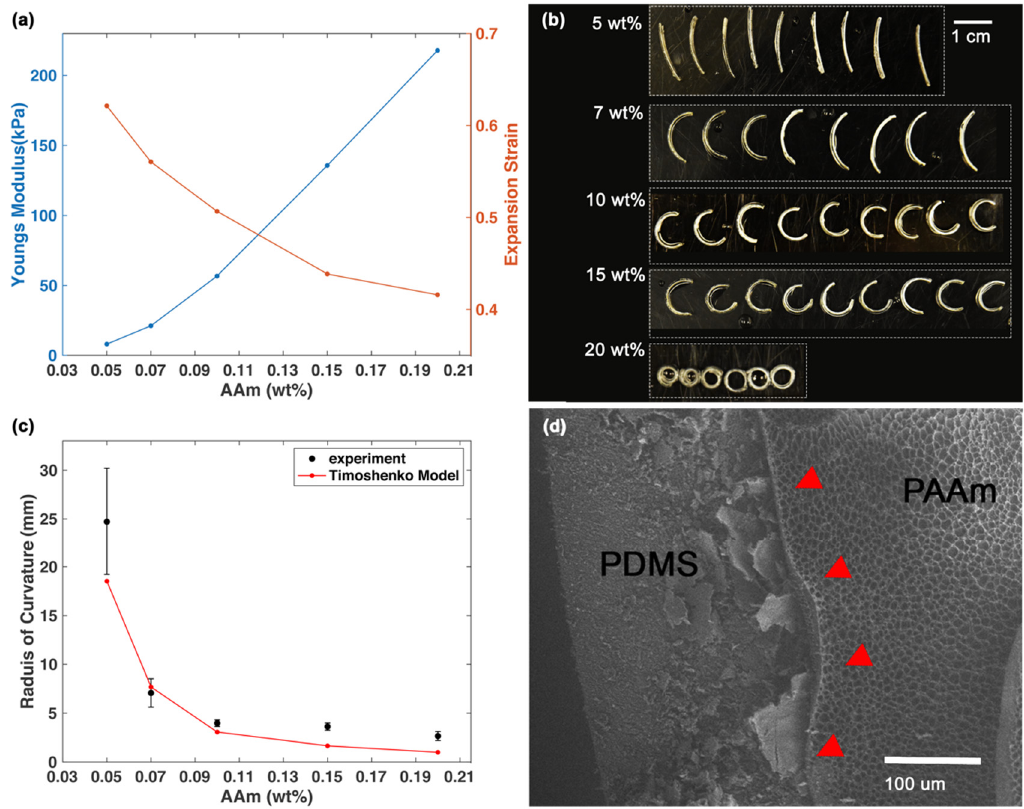
Figure 2. Characterizations of hydrogels and curvature measurement of bilayer strips. ( a ) Young’s modulus and expansion strain of hydrated hydrogels with different AAm initial concentrations. ( b ) Hydrated bilayer strips (17 mm × 2.5 mm (length × width)) with different AAm wt%. Images were captured with samples on a dry surface to allow consistent arrangement of the samples, but the dry environment slightly affected the curvature. The images used for curvature analysis were taken with the samples in deionized (DI) water. The scale bar is 1 cm. ( c ) The radius of curvature of bilayer strips with different initial monomer concentrations. The black dots represent experimental data. The sample size is six for bilayer with 20 wt% AAm and nine for other concentrations. The error bar represents standard deviation. The red line represents simulation results from Timoshenko model. ( d ) SEM image of the bilayer interface (red arrows) with 10% wt% AAm initial monomer concentration. This sample underwent swelling, then freeze-drying. The scale bar is 100 μm . The contrast was enhanced (Adobe Photoshop).